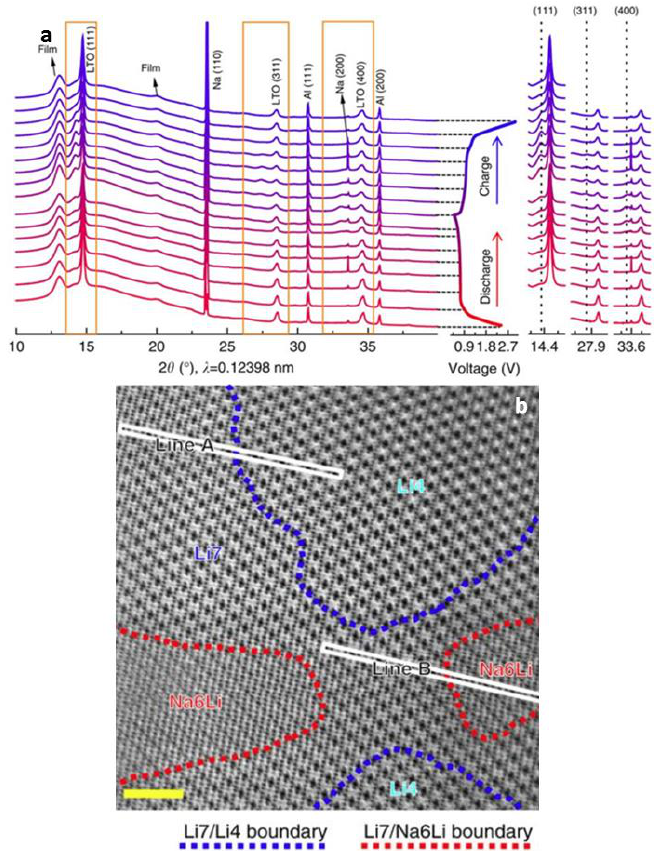
Figure 14. ( a ) In-situ synchrotron XRD patterns of the Li 4 Ti 5 O 12 electrode in a sodium-ion battery collected during the first cycle. For the Li 4 Ti 5 O 12 /Li 7 Ti 5 O 12 phases, the main peaks correspond to (111), (311) and (400) reflections, highlighted at the right and peaks of the Na 6 LiTi 5 O 12 phase are marked by black dotted lines. ( b ) An annular-bright-field STEM image showing a three-phase area from a partially electrochemically sodiated Li 4 Ti 5 O 12 nano-particle, Scale bar, 2 nm [60]; with permission from Springer Nature.